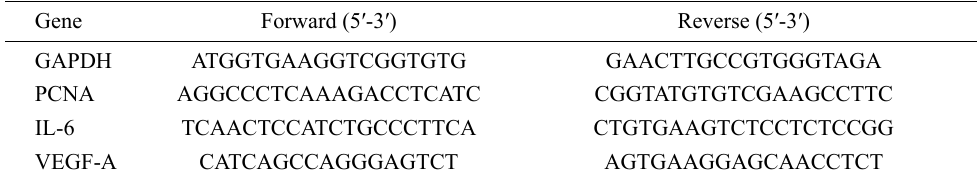
Table 1. Sequence of primers used for qRT-PCR.